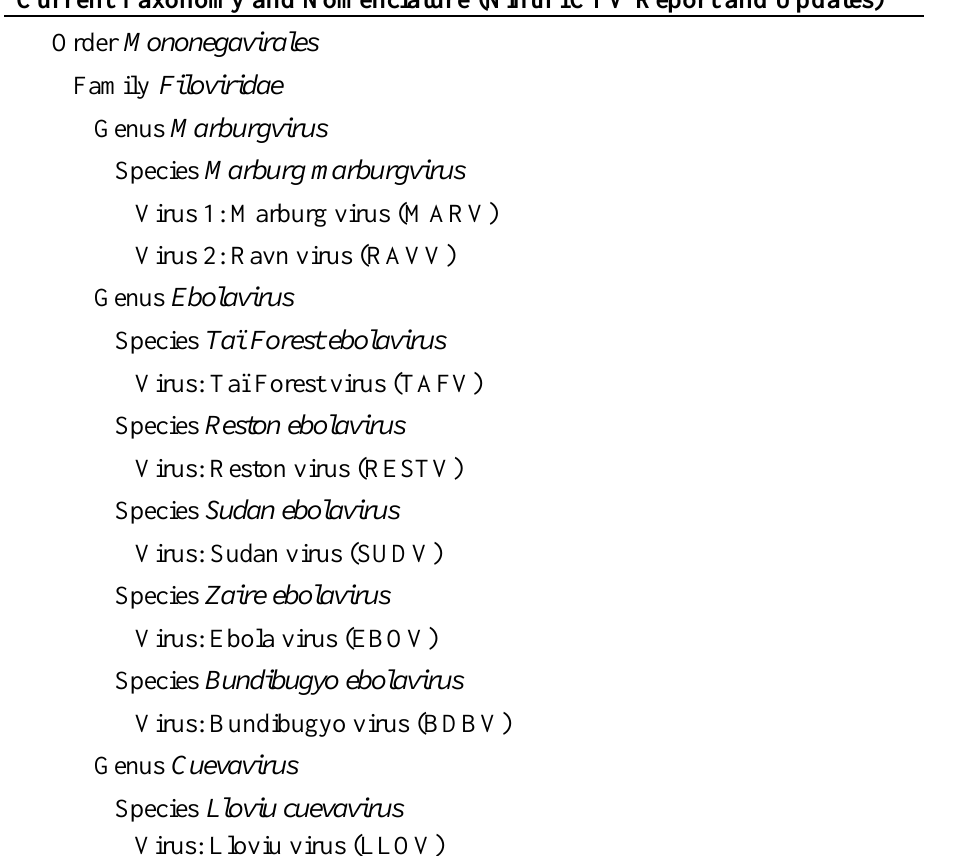
Table 1. Summary of the current filovirus taxonomy endorsed by the 2012-2014 ICTV Fi- loviridae Study Group and accepted by the